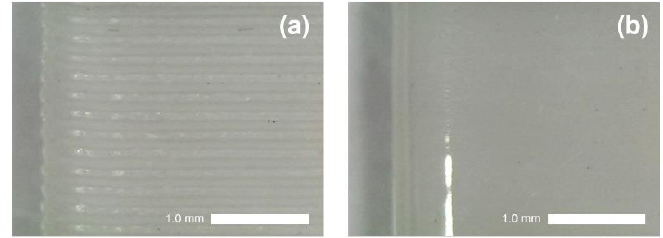
Figure 2. Optical microscope images of 3D-printed specimen ( a ) before and ( b ) after surface treatment (acetone vapor smoothening).